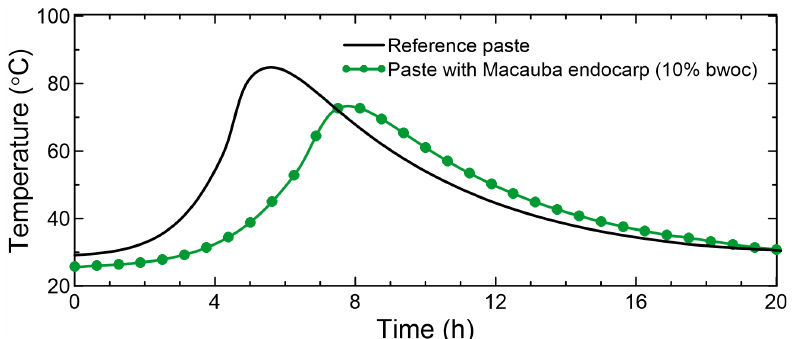
Figure 9. Temperature curves from the semi-adiabatic calorimetry test for reference cement paste and paste with crushed endocarp.